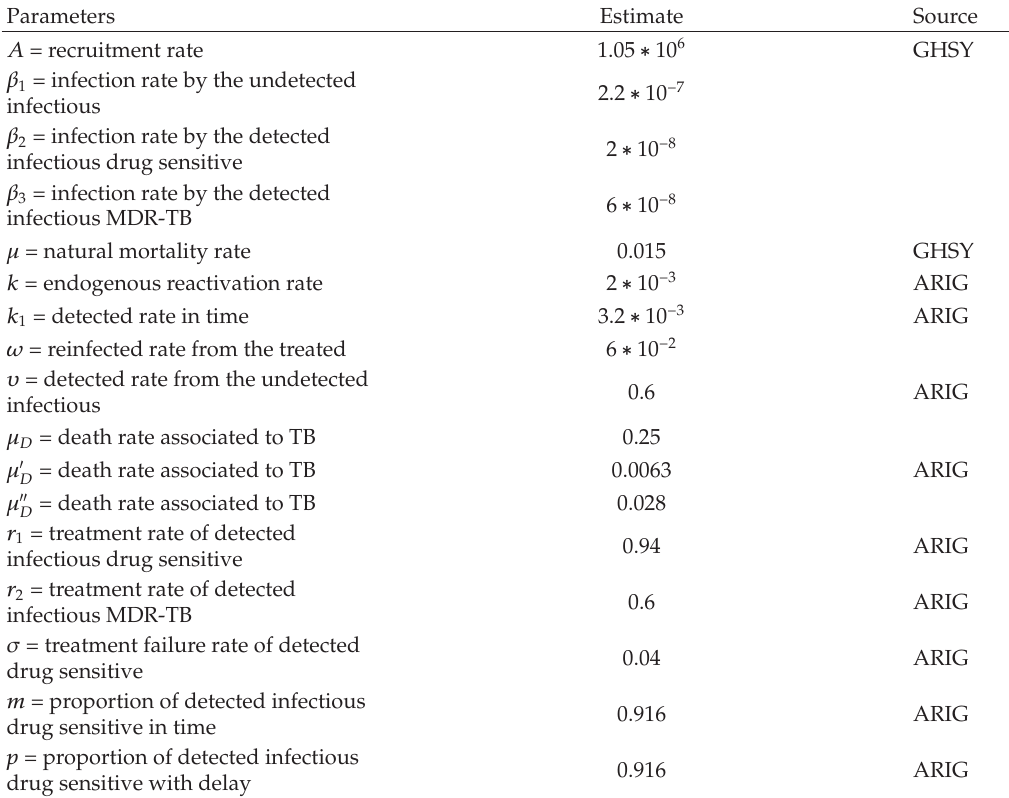
Table 1: Model parameters for